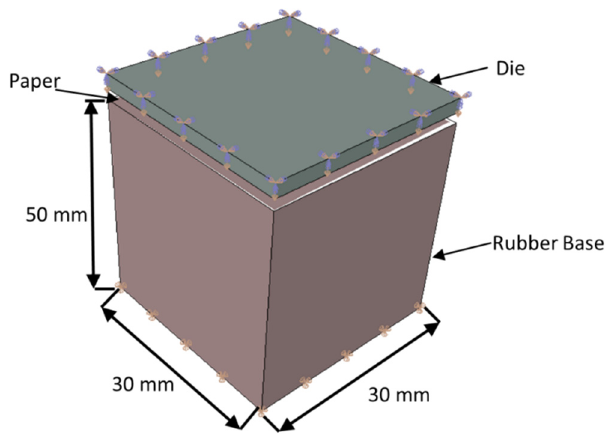
Figure 3. Model dimensions and boundary conditions.